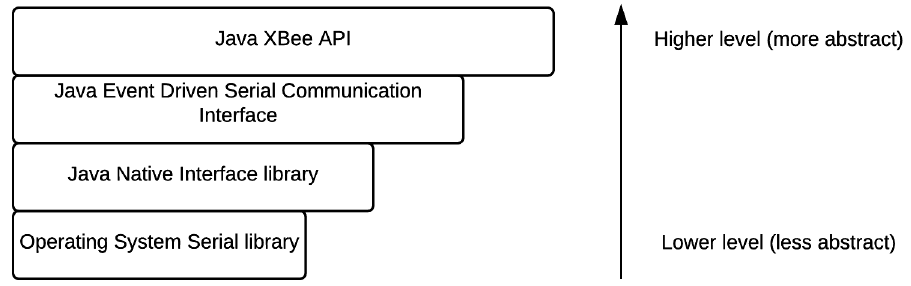
Figure 12. Abstraction layers from the operating system to the application code. API: Application program interface.